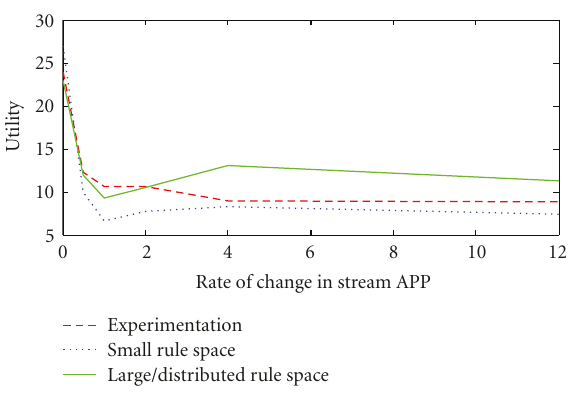
Figure 9: Comparison of utilities ( × 0.01) achieved by di ff erent rule spaces under di ff erent levels of dynamics.